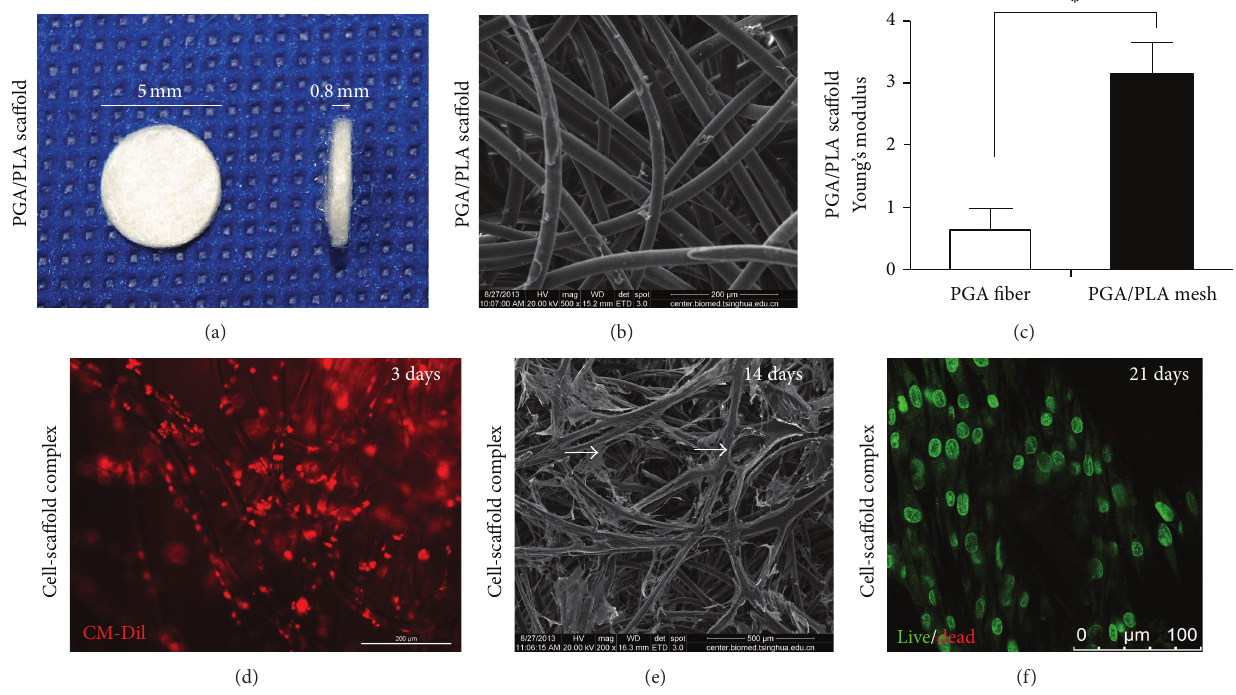
Figure 2: Characterization of PGA/PLA mesh and hADSCs-PGA/PLA complex. Cylinder-shaped PGA/PLA mesh (a). SEM examination of PGA/PLA polymer (scale bars: 200 𝜇 m, (b)). Mechanical property of PGA fiber alone and PGA/PLA complex (c). CM-Dil labeled (stained red) hADSCs-PGA/PLA complex 3 days after seeding (scale bars: 200 𝜇 m, (d)). SEM examination of hADSCs-PGA/PLA complex with an initial cell seeding density of 10 × 10 6 /mL cultured 14 days after seeding (scale bars: 500 𝜇 m, (e)). Live (stained green) and dead staining (stained red) of hADSCs-PGA/PLA complex 21 days after seeding visualized by laser confocal microscopy (scale bars: 100 𝜇 m,